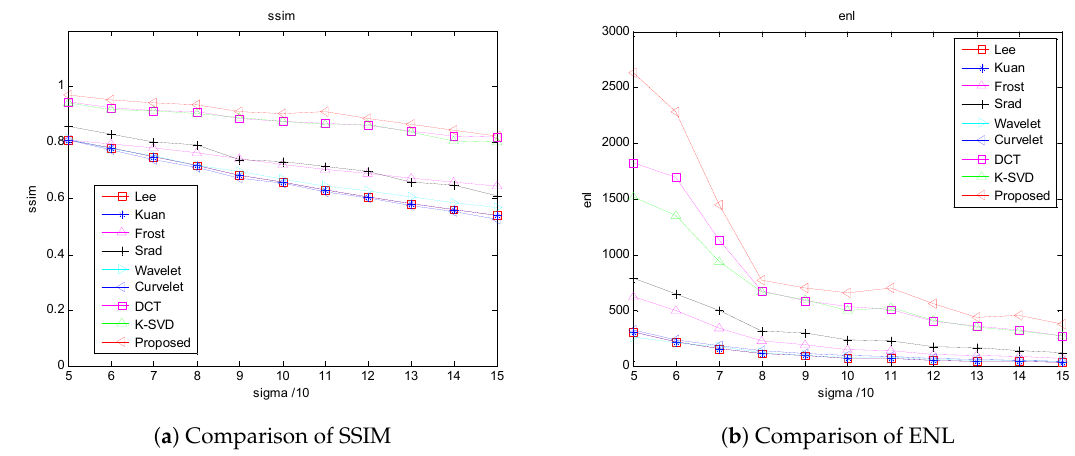
Figure 6. Comparison of the objective evaluation values.